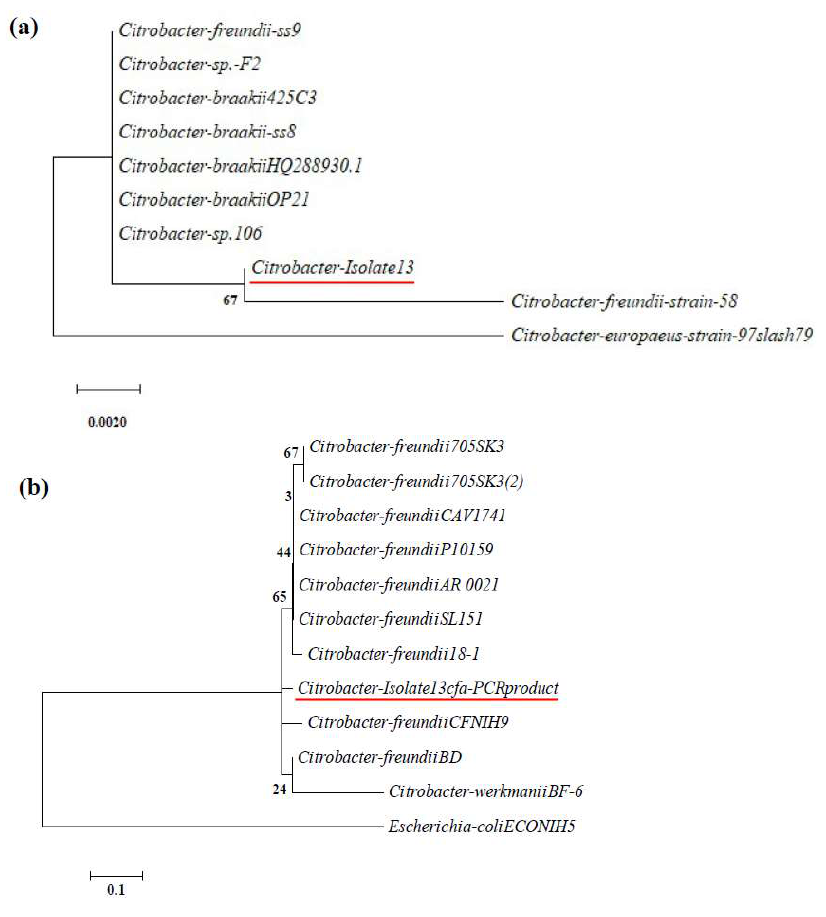
Figure 2. Phylogenetic trees of clustering ( a ) 16S rRNA gene fragment (200bp) among Citrobacter spp., and ( b ) cfa gene sequences (100 bp) from the Citrobacter freundii strains.